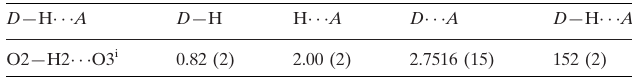
Data collection